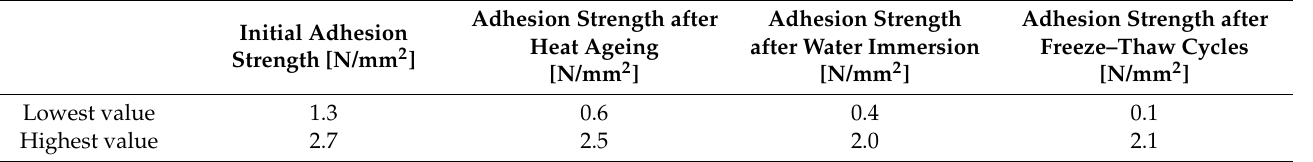
Table 3. The lowest and highest values of the initial tensile adhesion strength, tensile adhesion strength after heat ageing, tensile adhesion strength after water immersion, and tensile adhesion strength after freeze–thaw cycles of CTA obtained by 27 laboratories participating in the ILC.